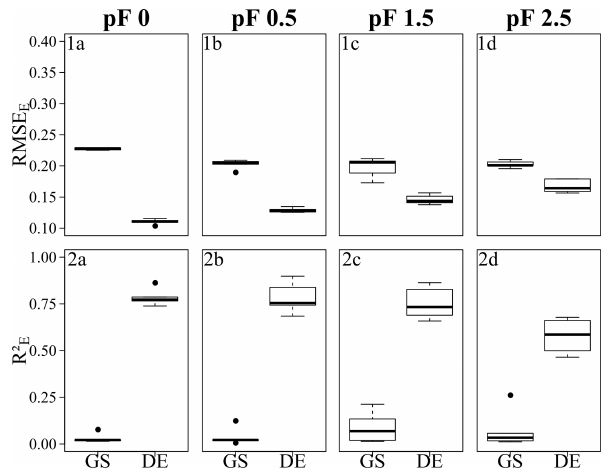
Figure 6. Error metrics of the Quinuas BRT models, showing (1a– d) RMSE E and (2a–d) R 2 for (1a, 2a) pF 0, (1b, 2b) pF 0.5, (1c, E 2c) pF 1.5, and (1d, 2d) pF 2.5. Each boxplot is based on five values resulting from five CV repetitions. GS refers to grid search, and DE refers to the differential evolution algorithm. Error metrics were calculated based on response variables scaled to the range [0,